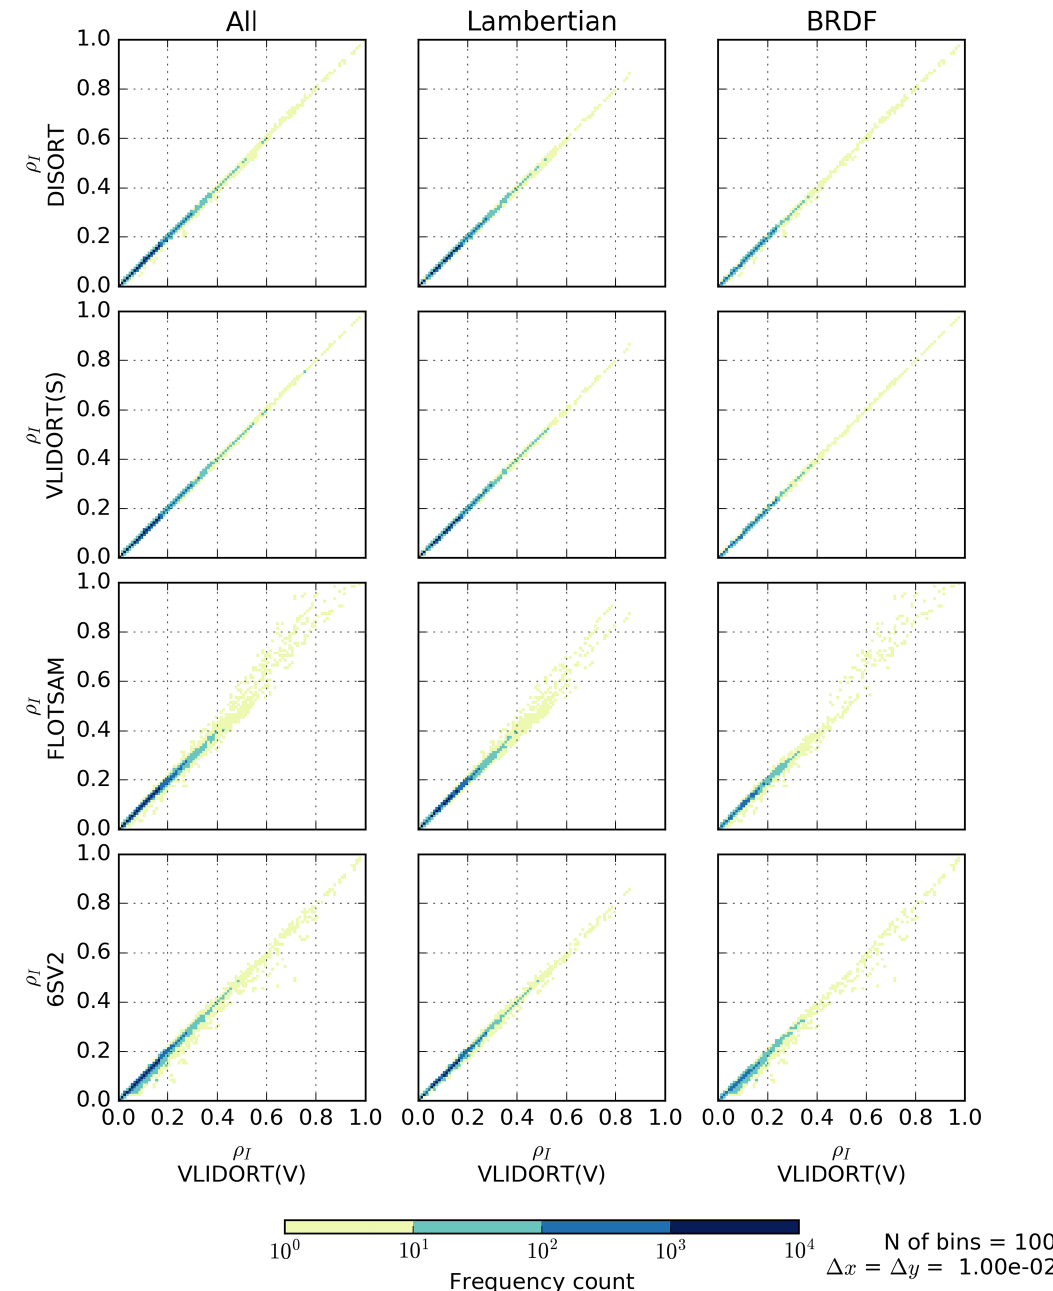
Figure A1. Two-dimensional density plots of the simulated reflectances for the 6SV2, FLOTSAM, DISORT, and VLIDORT (scalar) models versus those of the VLIDORT (vector) model. The plots in the left column mix all 44080 cases, while those in the middle and right columns are for the Lambertian and BRDF surface cases,